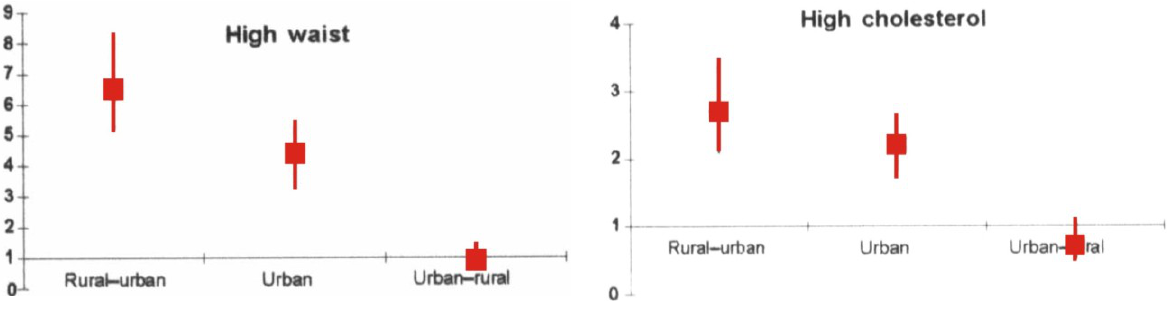
Figure 2. Age-adjusted ORs and 95% CIs for prevalence of cardiovascular risk factors in different groups of women (rural-urban, urban and urban-rural migrants) as compared with the rural women, high prevalence of high waist circumference ≥80 cm, and hypercholesterolemia ≥200 mg/dL among rural-urban migrants and urban women. The prevalence declines among the urban-rural migrants. Note: this figure is reproduced with permission from [49]. Copyright the BMJ Publishing Group Ltd.,